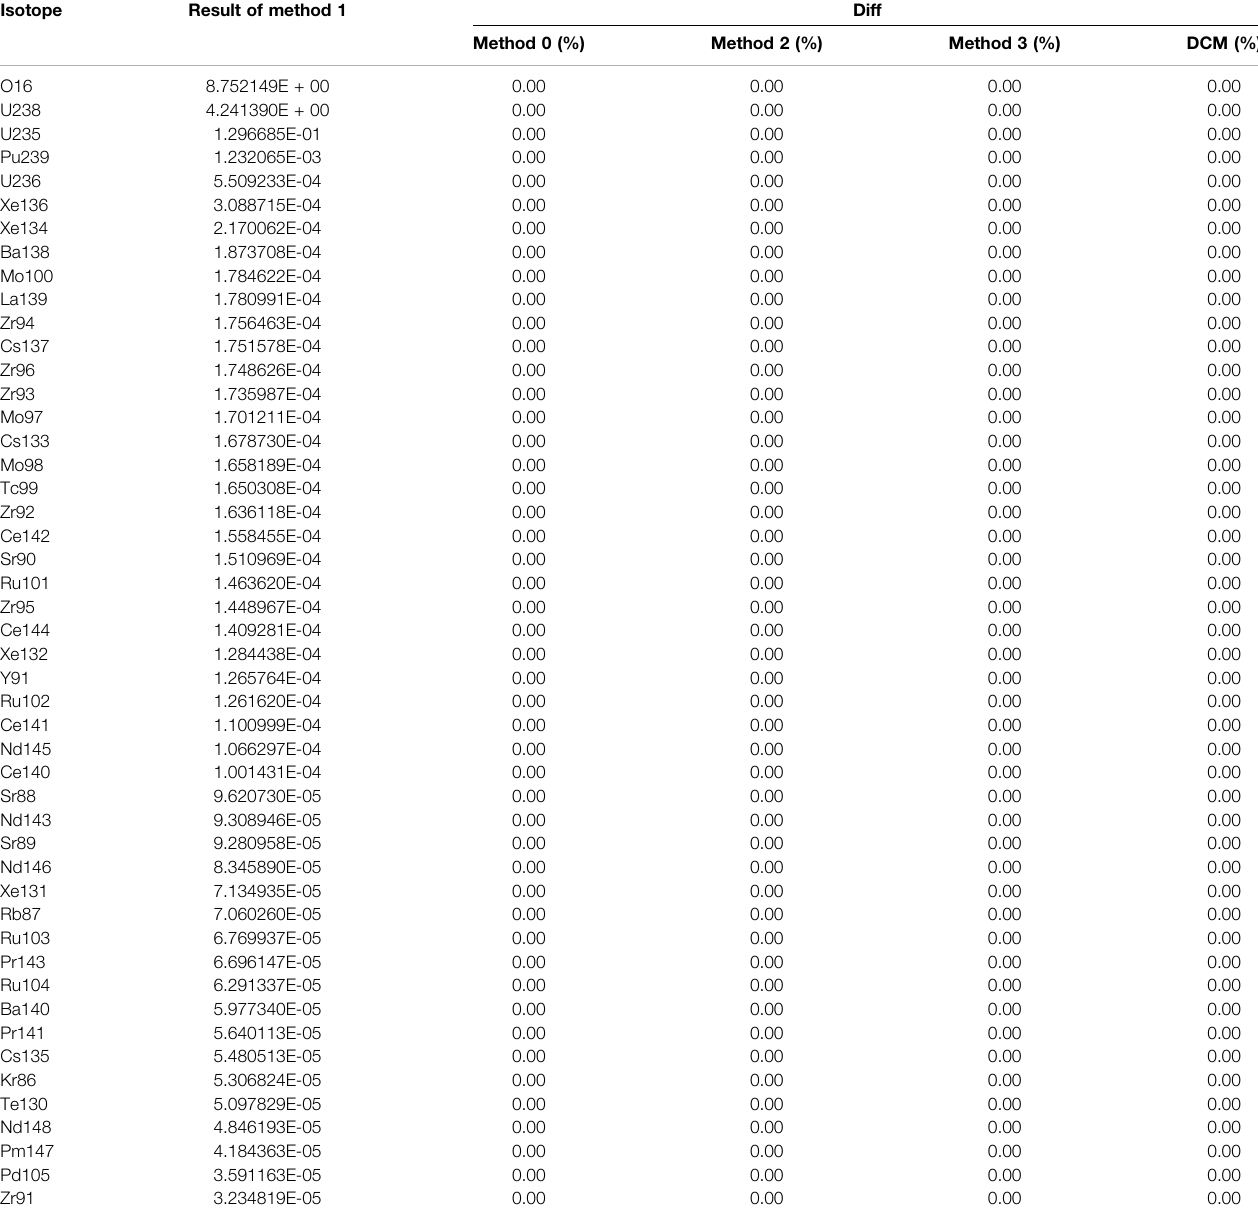
TABLE 3 | Atomic densities and differences between different algorithms of top 50 isotopes. Isotope Result of method 1